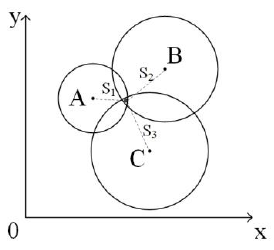
Figure 2. Trilateral centroid localization algorithm.